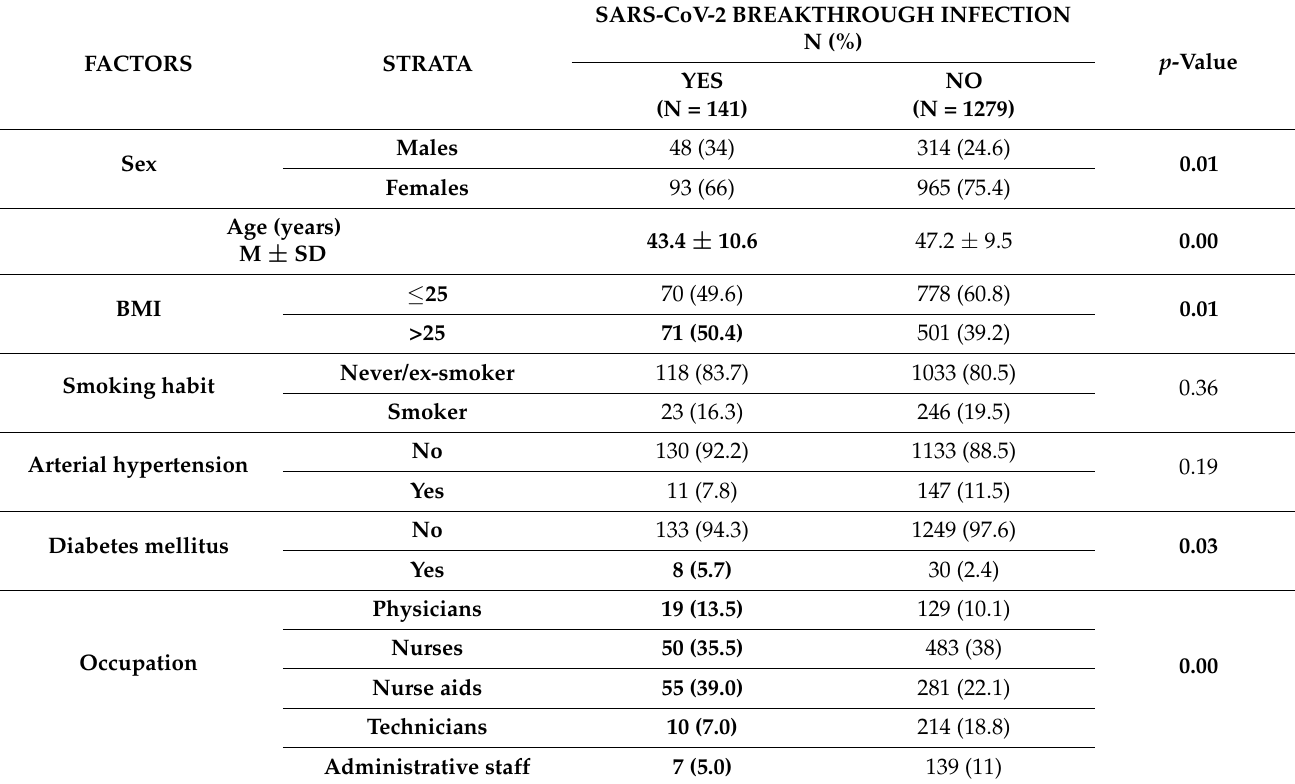
Table 3. Distribution of vaccinated healthcare workers of Trieste hospitals by explanatory factors and SARS-CoV-2 breakthrough infection. Number (N), column percentage (%) and p -value of chi- square (for categorical terms) or t -test (for linear terms). Bold numbers serve to highlight statistically significant